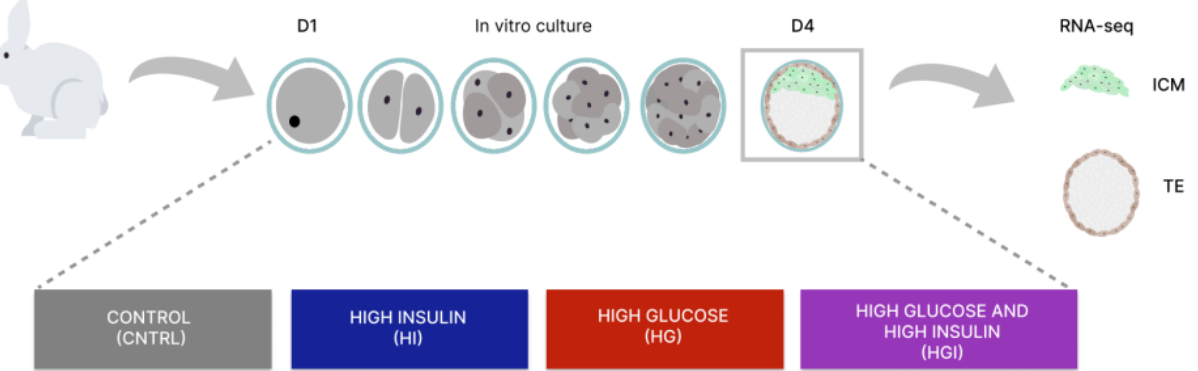
Figure 1. Schematic representation of the experimental workflow to analyze the in vitro exposure of preimplantation embryos from 1-cell to blastocyst stage for control, high insulin, high glucose, and high glucose and high insulin. The inner cell mass (ICM) and trophectoderm (TE) transcriptomes were determined by RNA-seq. D1, day 1. D4, day 4. Table 1. Developmental competence of rabbit preimplantation embryos developed in vitro in CNTRL, HI, HG, or HGI conditions. Values are expressed as emmeans with standard errors in parenthesis. Different superscript letters (a, b) indicate significant differences within the same column ( p <